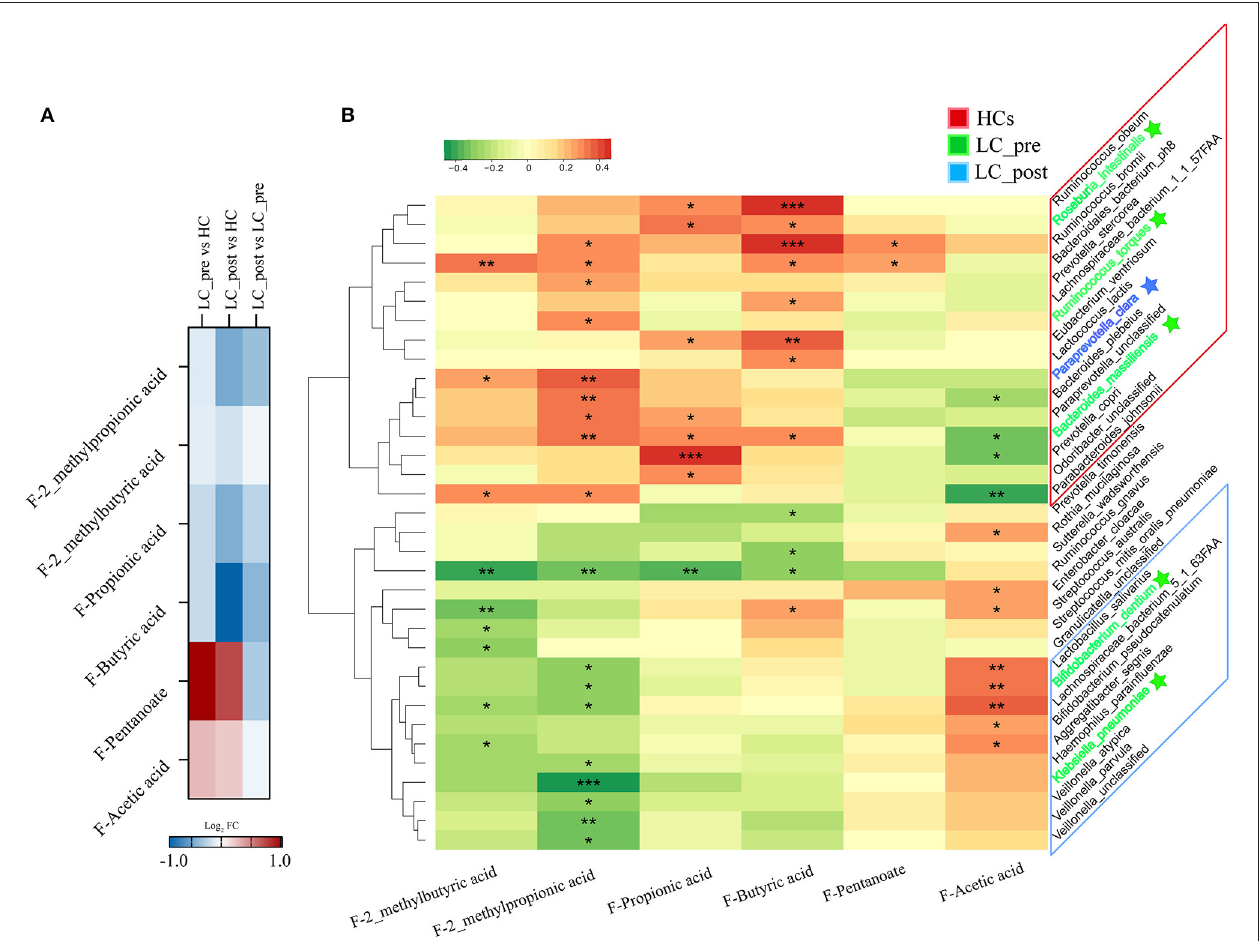
FIGURE 5 | Effect of lactitol on fecal SCFAs. (A) Heatmap of fecal SCFAs. (B) Correlation between fecal SCFAs and discriminatory species. SCFAs, short chain fatty acids; LC-pre (green), cirrhotic patients before lactitol intervention; LC-post (blue), cirrhotic patients before after lactitol intervention; HCs (red), healthy controls. * p < 0.05, ** p < 0.01, *** p <